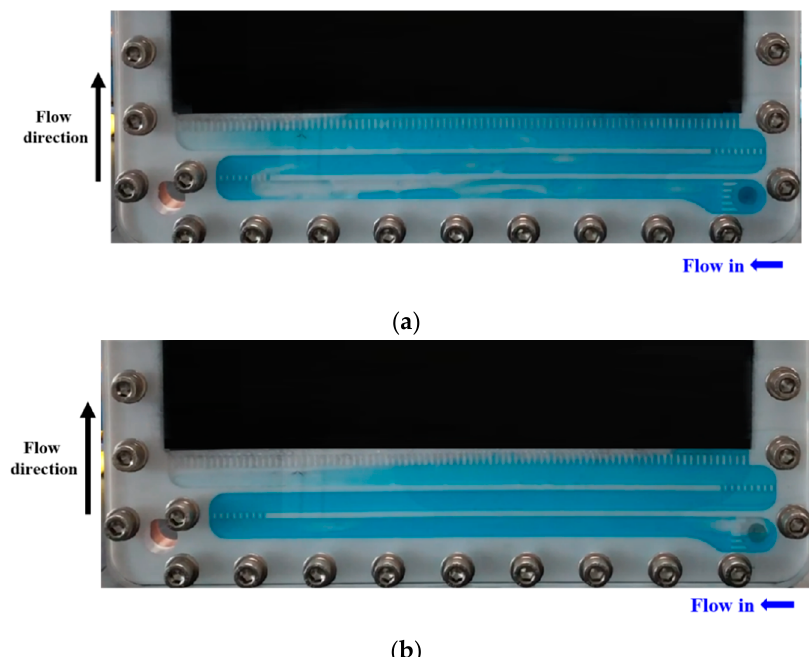
Figure 7. Results of flow visualization experiment. ( a ) Flow time t = 3 s; ( b ) Flow time t = 4 s.